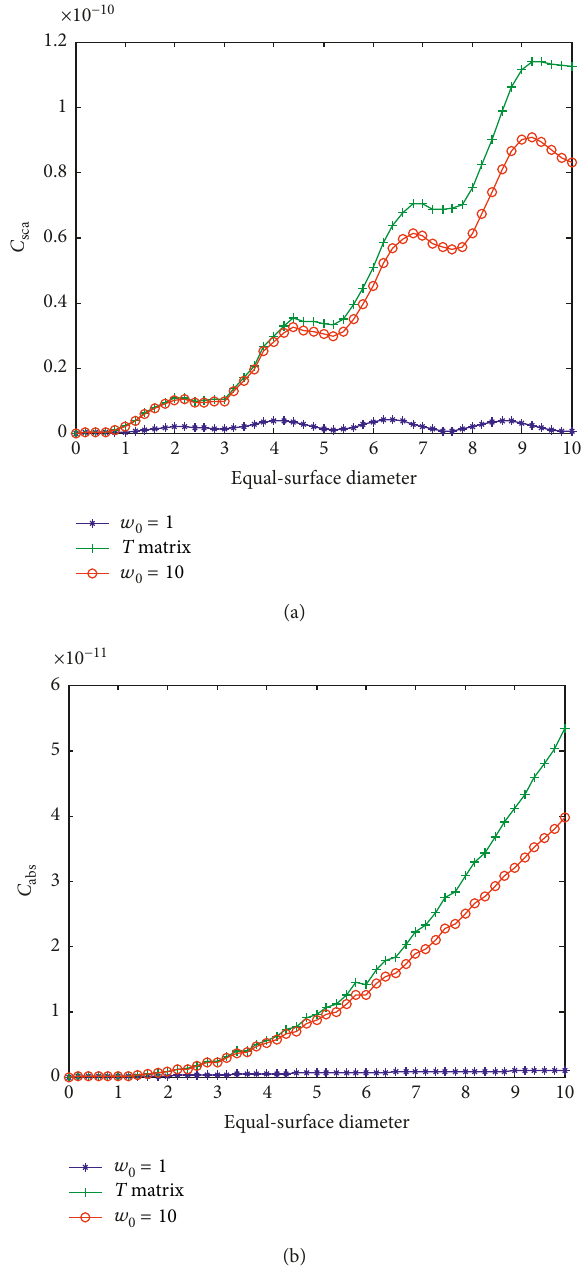
Figure 9: Scattering and absorbing cross sections of spheroid particles ( λ 1.2, m 1.5+0.01 i (cid:31) (cid:31)